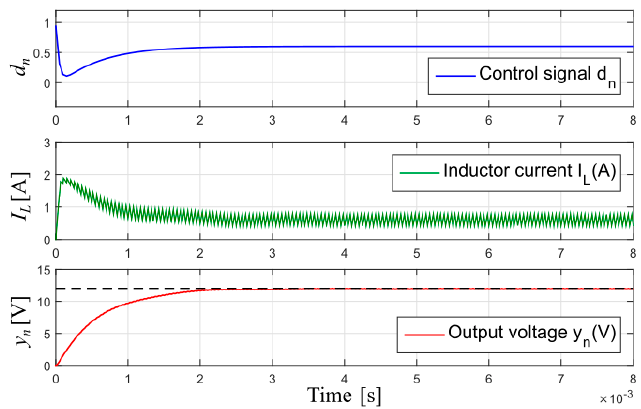
Figure 8. Simulated control signal, inductor current and output voltage under step variation of the reference value from 0 V to 12 V using the proposed control method.